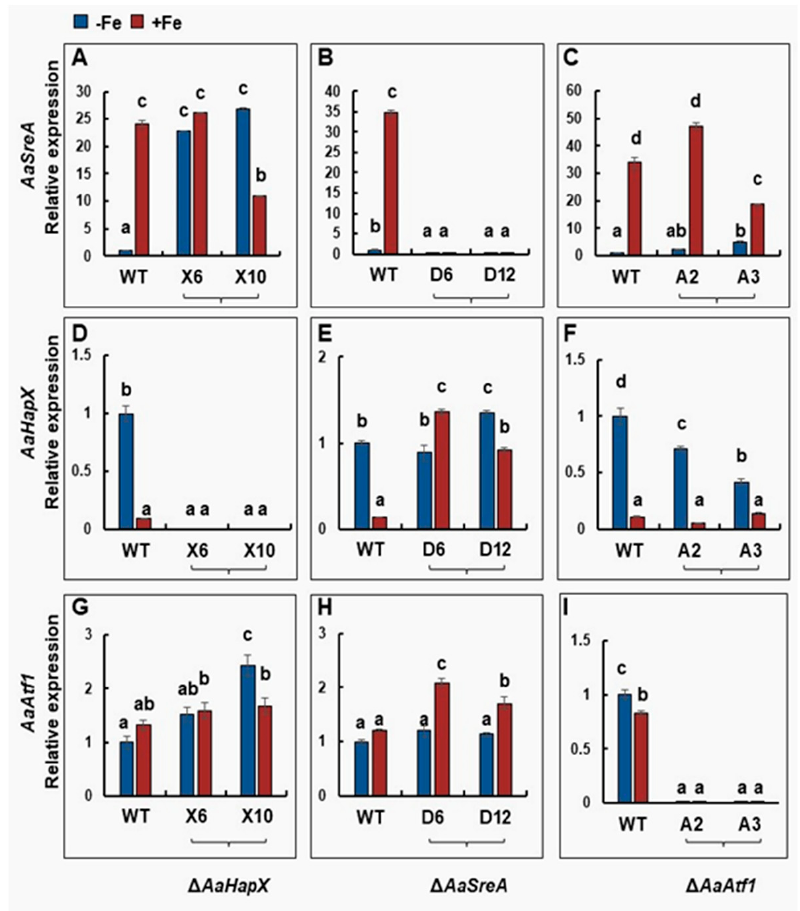
Figure 4. Quantitative real-time PCR analyses of the expression of the AaSreA ( A – C ), AaHapX ( D – F ), and AaAtf1 ( G – I ) genes in A. alternata strains grown in the presence or absence of iron. Wild type, ∆ AaHapX (X6 and X10), ∆ AaSreA (D6 and D12), and ∆ AaAtf1 (A2 and A3) were grown in PDB at 28 °C for 2 to 3 days. Mycelium was harvested, washed with water, transferred into liquid MM or MM amended with 0.2 mM FeCl3, and incubated for an additional 24 h. RNA was purified from mycelium and used for first-strand cDNA synthesis. Quantitative RT-PCR was performed using gene-specific primers. The relative expression level from three independent reactions was calculated by a comparative Ct method ( ∆∆ CT) in relation to the expression of the fungal β -tubulin-coding gene. In each assay, the expression level in the wild type grown in MM was set to 1. Means indicated by the same letter are not significantly different, p < 0.05. All experiments were repeated at least two times, showing similar trends.